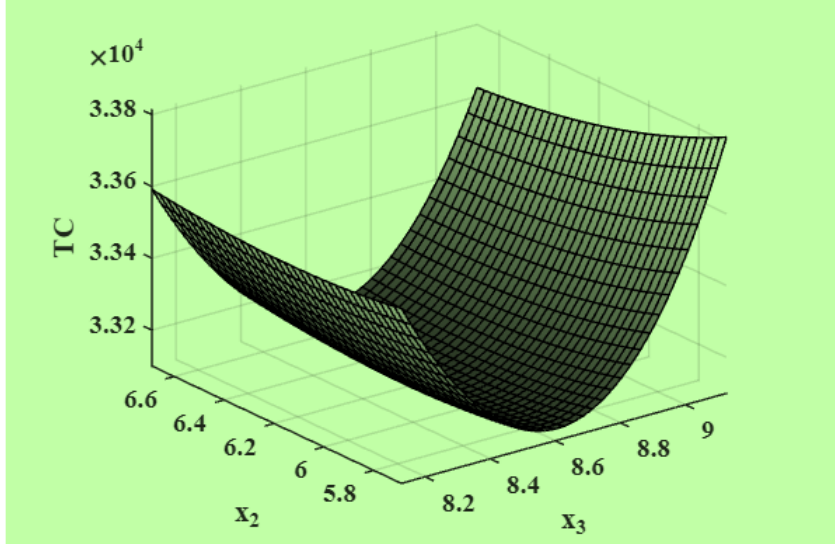
Figure 2. Diagrammatic representation of the cost function.